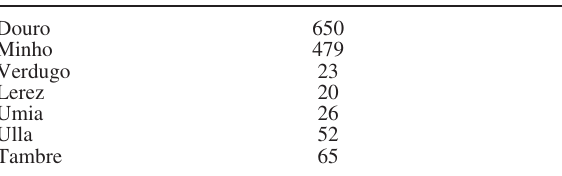
t able 2. – River mean run-off (m 3